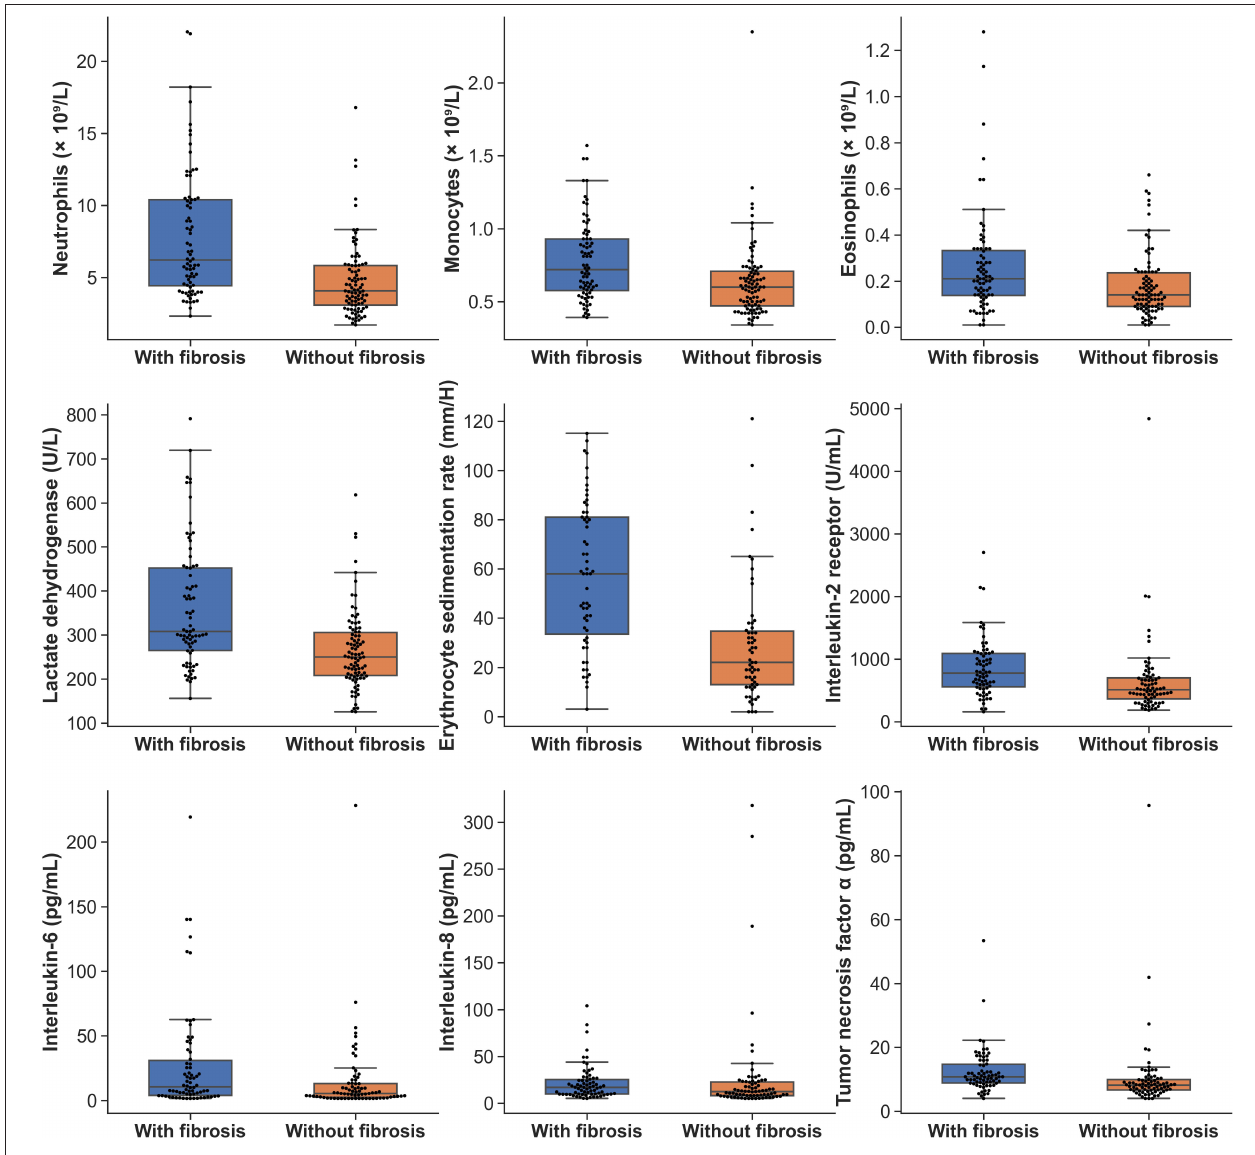
FIGURE 2 | The boxplots of laboratory parameters of patients in the two